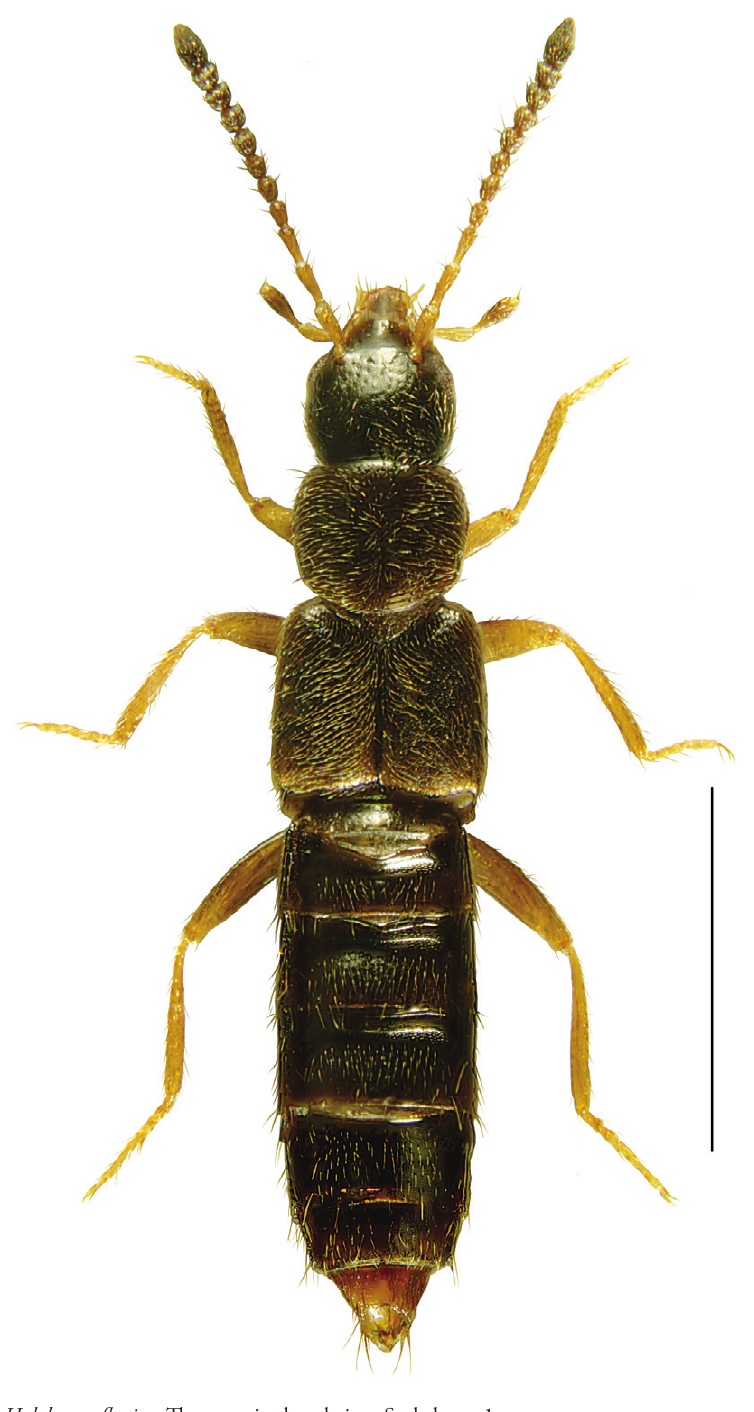
Fig. 15. Halobrecta fl avipes Th omson in dorsal view. Scale bar = 1